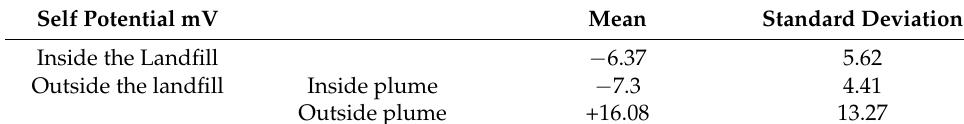
Table 1. Mean SP Values and standard deviation inside and outside the landfill.